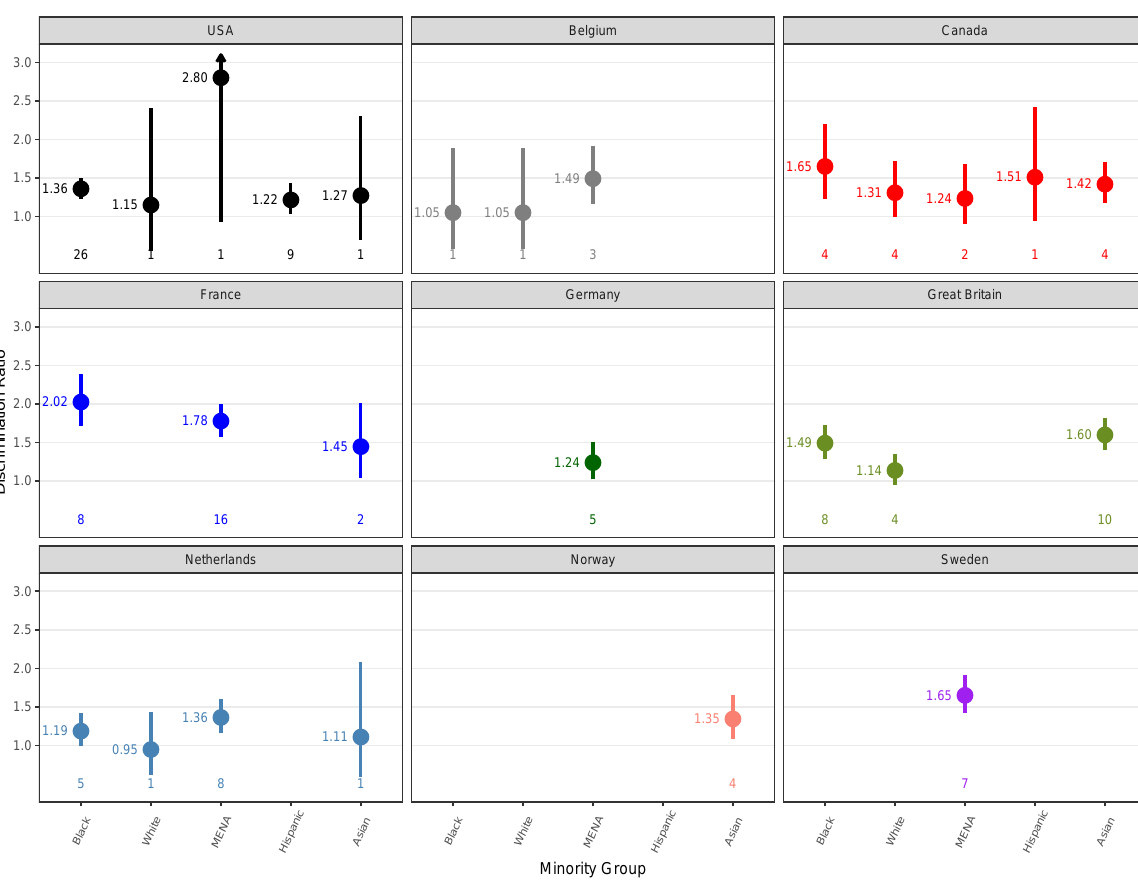
Figure 1: Average discrimination ratios by country and target group. Lines are 95 percent confidence inter- vals. The number left of the line is the point estimate. The number below the line is the number of studies used to compute